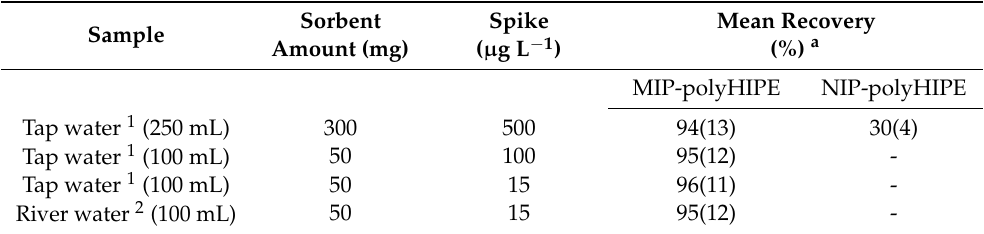
Table 3. Mean recovery of IRB from natural waters by MIP-polyHIPE SPE.